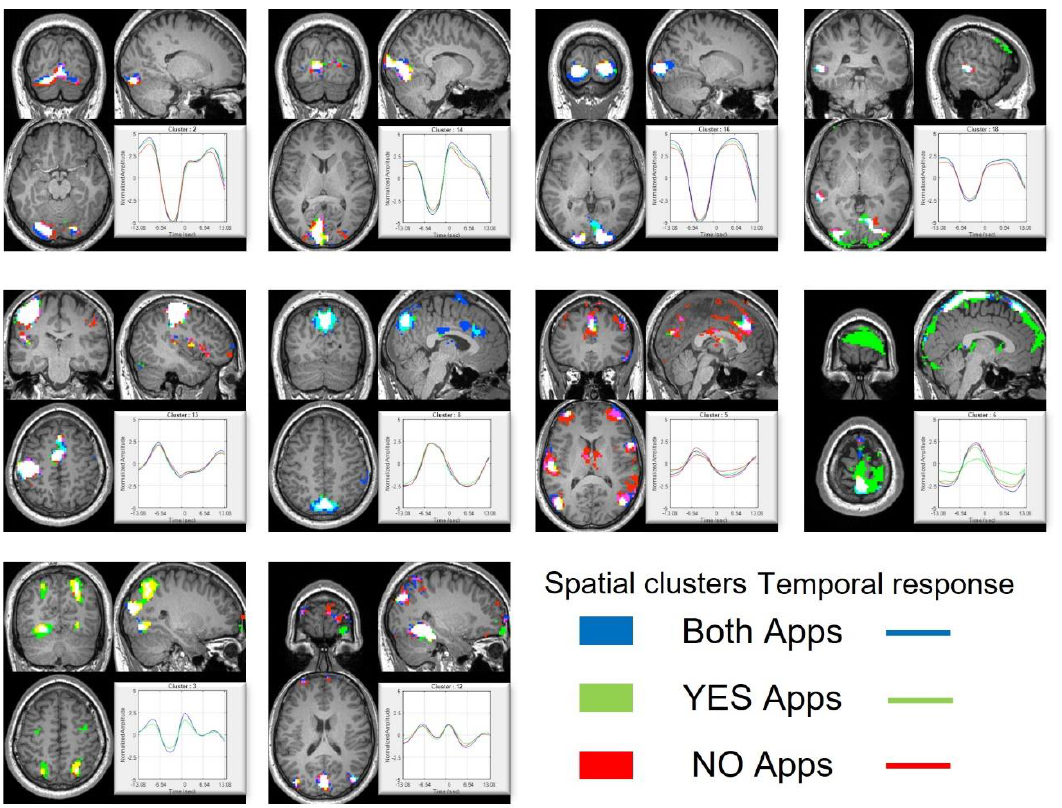
Figure 6. Spatial and temporal results for k-means clustering. Figure shows some of the clusters with meaningful temporal and spatial response. The response for ‘yes’ apps is shown in green, ‘no’ apps is shown in red and the case for all user decision (either yes or no) is shown in blue. Before the decision is made (indicated by a button press), activity peaks for cluster 5.